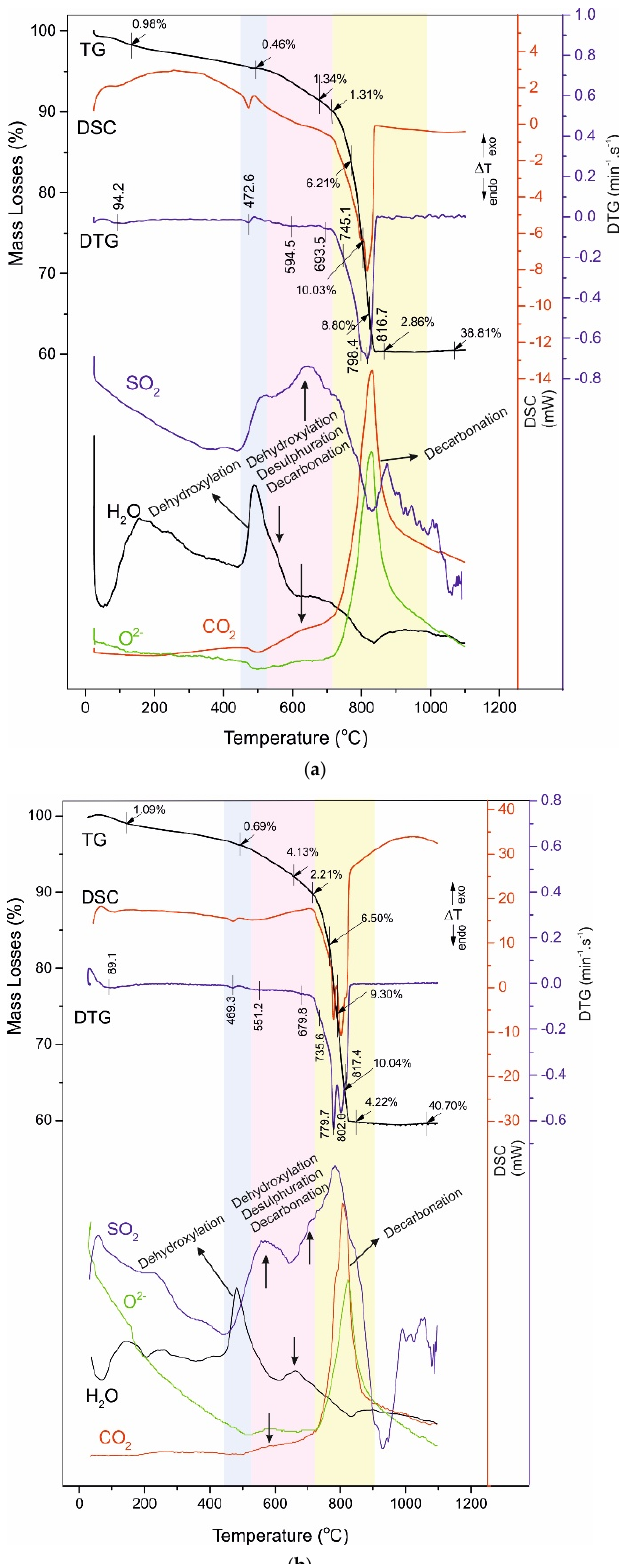
Figure 10. ( a ) TG-DTG-DSC curves of C028. ( b ) TG-DTG-DSC curves of C120. The temperature intervals in which thermal processes take place are marked with a different color background. IV th Decarbonation and Desulphuration (730–850 ° С ) The decomposition of carbonate-containing phases (Figures 8–10, Table 6) of samples A, B, and C is performed at higher temperatures, compared to the raw Portland white cement and marble powder. Significant differences between the mass losses are measured (3.68% in the raw cement, 46.16% in the raw marble powder, and 30.06% in sample C120), defined by the different amounts of carbonate minerals. The temperature decomposition intervals are maintained without substantial changes. The marble powder decarbonation occurs with several parallel reactions at close temperatures, which results in the splitting of peaks in the DTG/DSC curves, seen at the samples B and C, as well. The multi-step decarbonation process indicates the thermal decomposition of various carbonate-containing phases—dolomite, Mg-rich-calcite, and hydrated calcium-alumi- nates. Their decomposition causes the splitting of the peaks in the DTG/DSC dependen- cies and changes in their intensity. The curve describing the CO 2 from the carbonate ions in the evolving gas analysis follows the course of the DTG/DSC peaks which is direct ev- idence of the overlapping thermal reactions in this interval. The use of dolomitic marble powder as aggregate slightly increases the temperature of decarbonation with the benefit of the samples В and C (Table 6, Figures 9 and 10). The most accurate explanation of this fact is the formation of dense structures, which affect the results of physic-mechanical analyses [15].